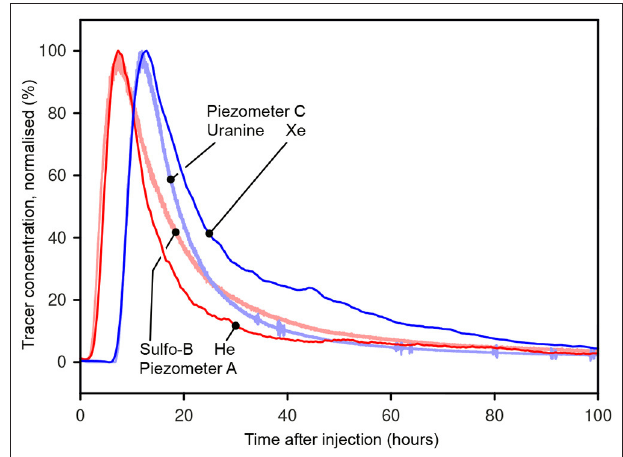
FIGURE 5 | Breakthrough curves from combined injections of noble gases and fluorescent dyes (He and sulforhodamine-B at piezometer A, Xe, and uranine at piezometer C).